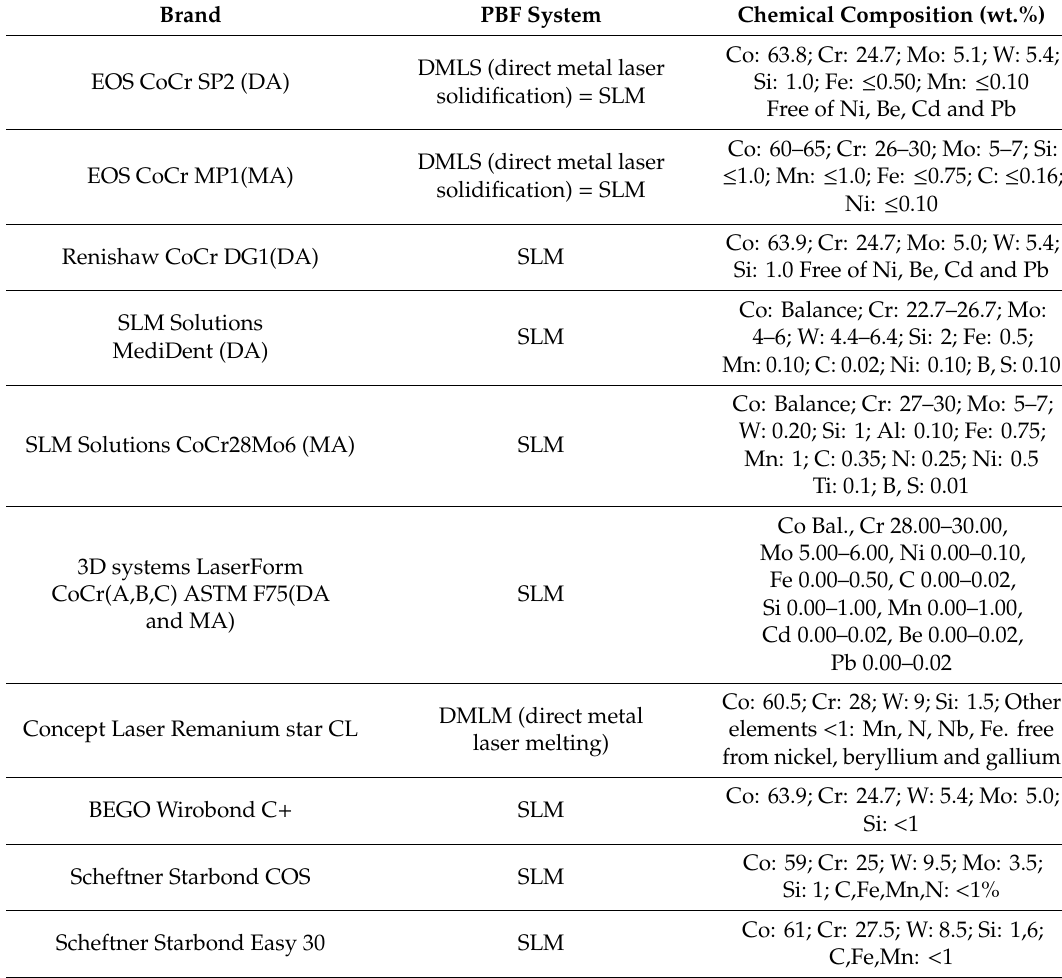
Table 2. Brands and chemical composition of CoCr alloys for dental (DA) and medical (MA) applications. Data from reference